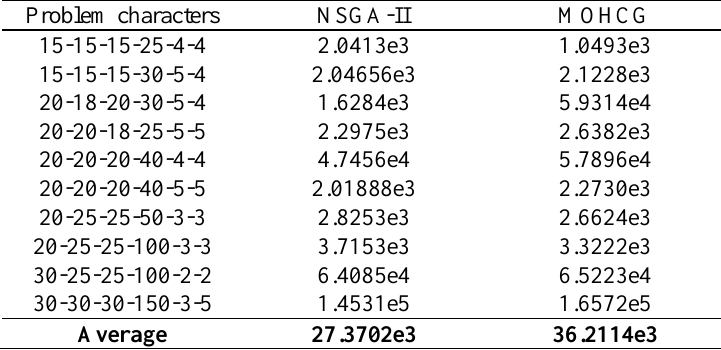
Table 6 . DM measure for medium/large sized instances Problem